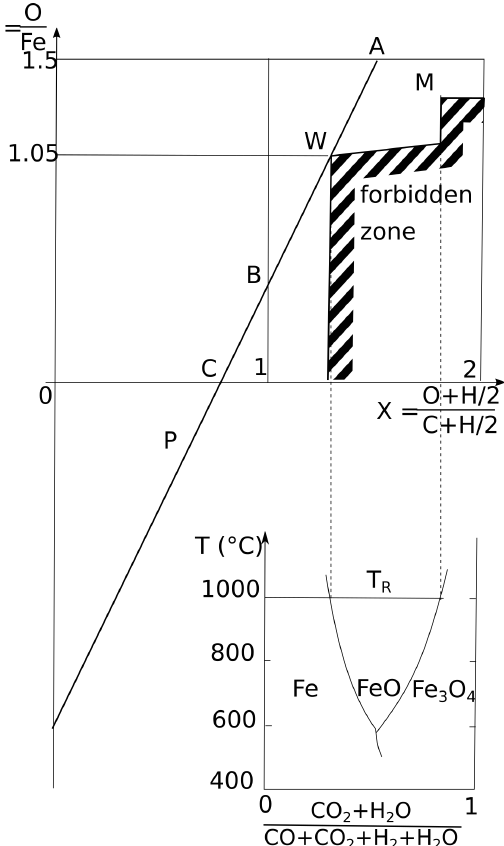
Figure 3. An illustration of the Rist diagram applied for the blast furnace, coupled with thermody- namics constraints from the Chaudron